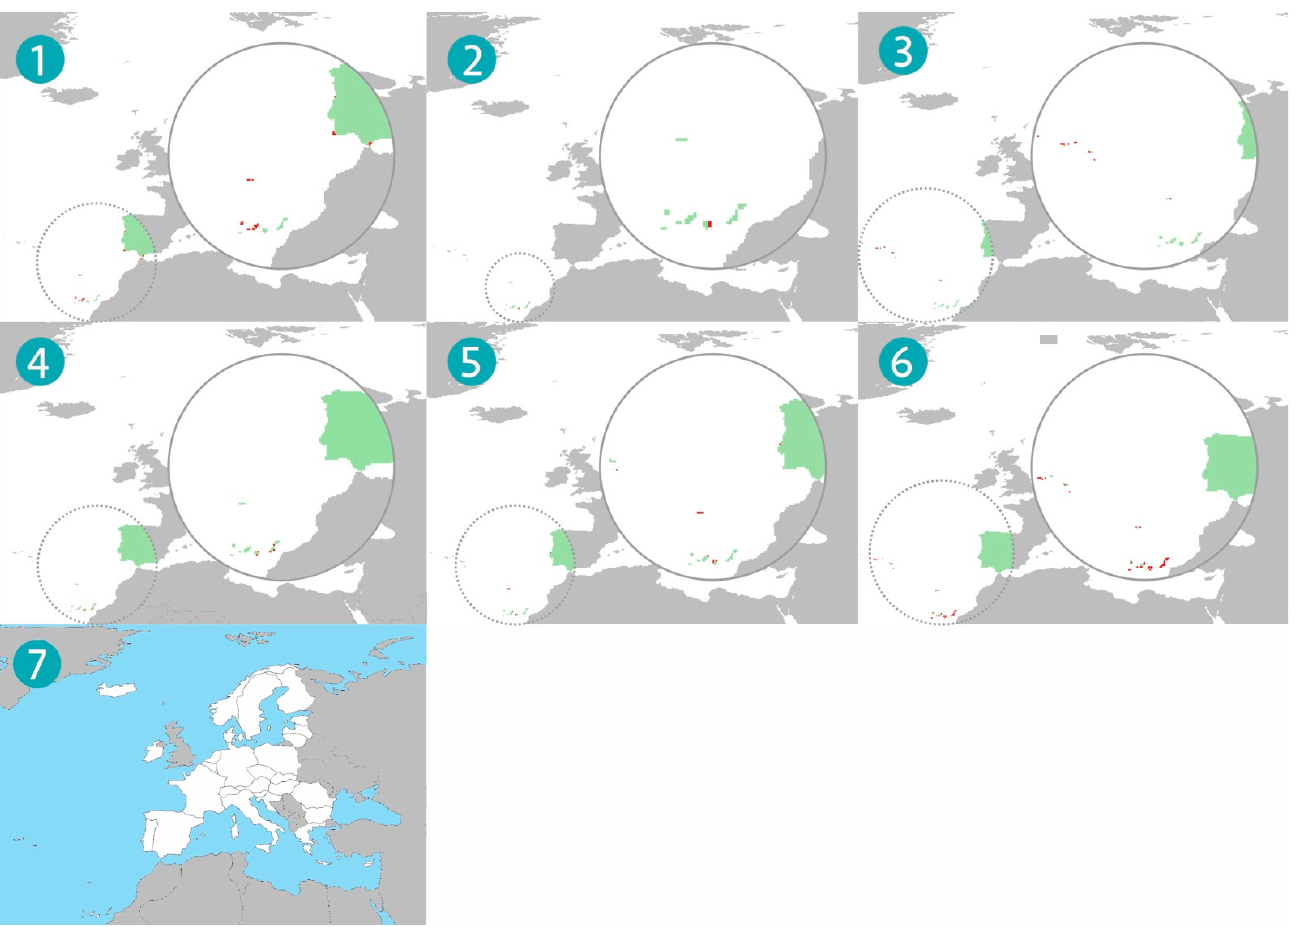
Figure 3. The prediction computed using the MaxEnt model of the pet-traded gastropods with potential occurrence in a “small area” of EU (= covering only Macaronesia in the southern part of the territory). The maps show suitability in red, representing a high probability of establishment for these species: ( 1 ) Achatina balteata , ( 2 ) Helicophanta magnifica , ( 3 ) Limicolaria aurora , ( 4 ) L. flammea , ( 5 ) Lissachatina fulica , and ( 6 ) L. reticulata ; ( 7 ) map of European Union and Macaronesia belonging to the EU.